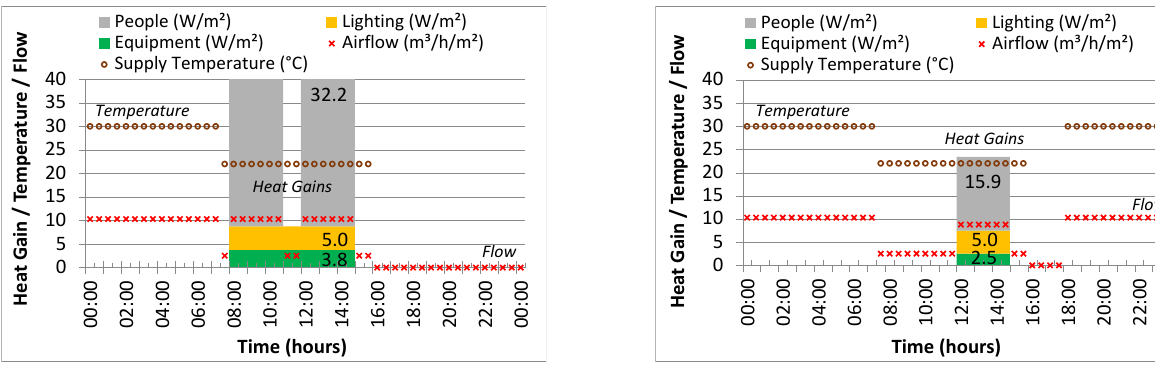
1 Figure 5. Photos of the test room with measurement points and internal heat sources.